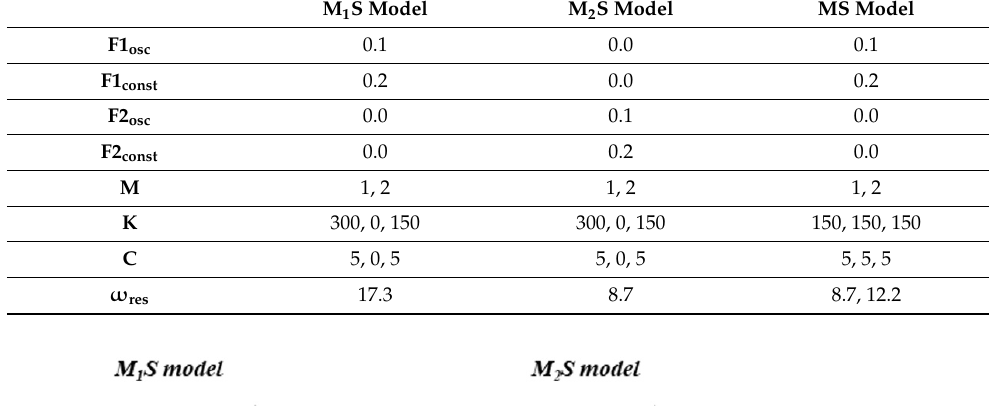
Table 1. Parameters of the MS model. Model’s parameters in the case of M 1 S (Figure 7A left), M 2 S (Figure 7A right), and MS (Figure 7C). Oscillating (F1 osc , F2 osc ) and constant (F1 const , F2 const ) components of the external force driving mass 1 (m 1 ) and mass 2 (m 2 ), vector of the two masses (M), vector of the three stiffness constants (K), vector of the three damping constants (C), and resonant frequencies of the three systems. M 1 S Model